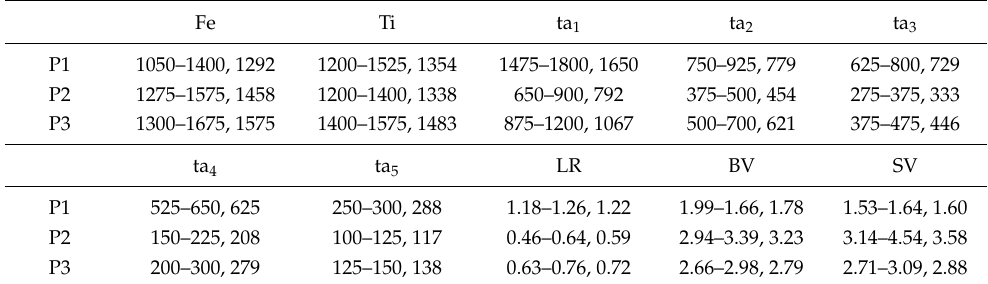
Table 4. Male adults of Microtendipes nigrithorax sp. nov. Length (in µ m) and proportions of leg ( n =